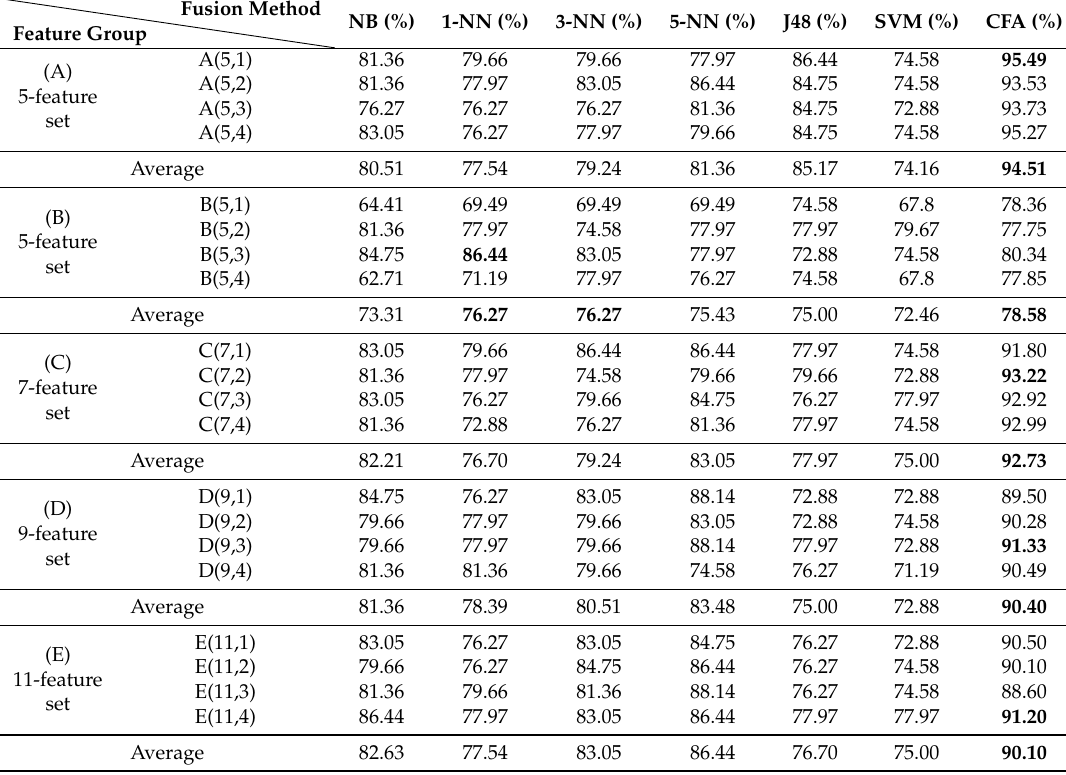
Table 5. Comparison of performance among fusion